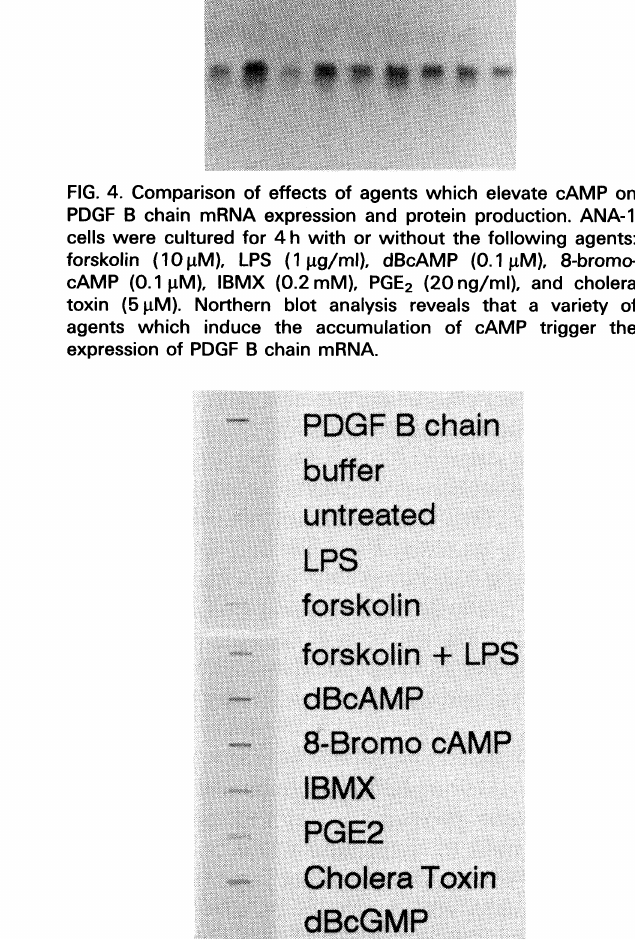
FIG. 5. Secretion of PDGF B chain protein by ANA-1 cells. Immu- noblot analysis of PDGF B chain protein indicates that PDGF B chain protein is produced and secreted by macrophages follow- ing treatment with cAMP-inducing